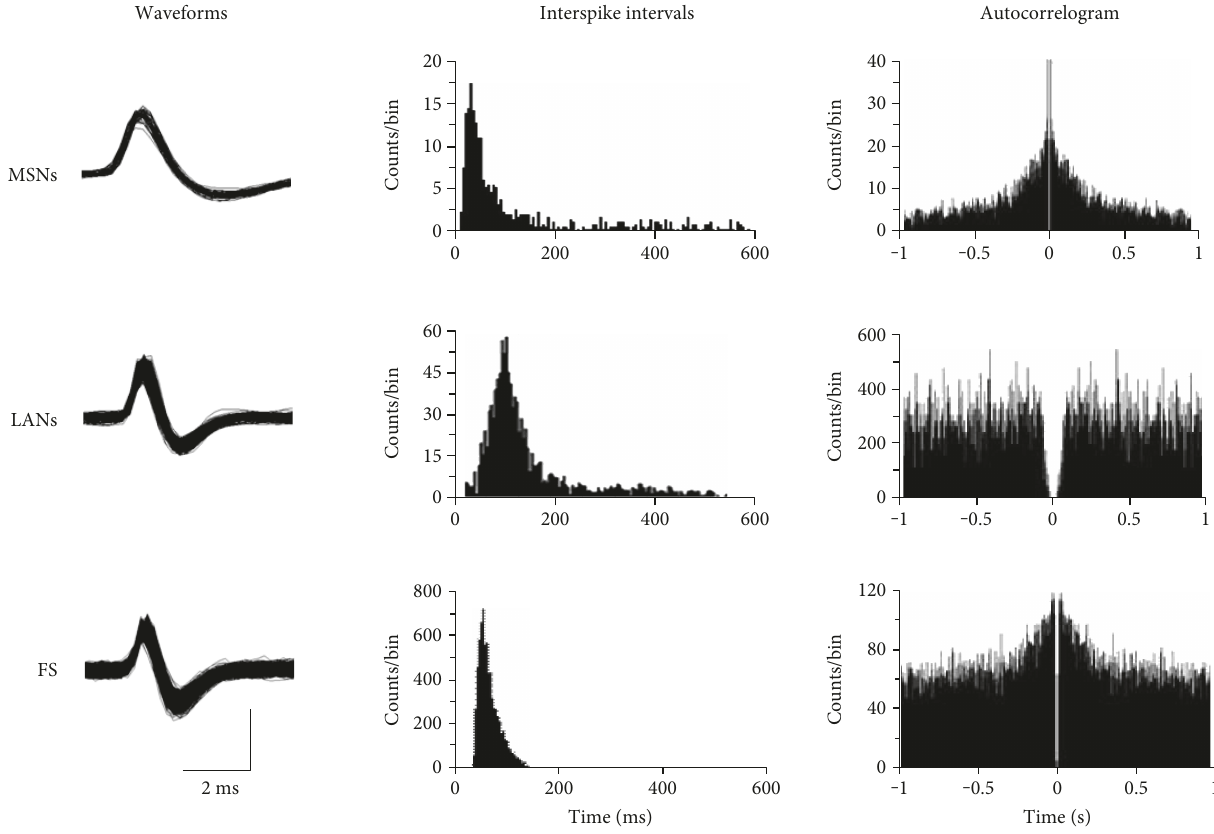
Figure 5: The spontaneous fi ring patterns of striatal neurons. Typical action potential waveforms (left column), interspike intervals (middle column), and autocorrelograms (right column) associated with medium spiny-like neurons (MSNs), large aspiny-like neurons (LANs), and fast-spiking interneurons